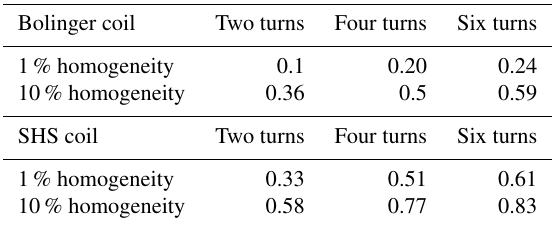
Table 4. Coil homogeneity efficiency summary (in the plane ge- ometry): comparison between the Everett–Bolinger coils and SHS coils.